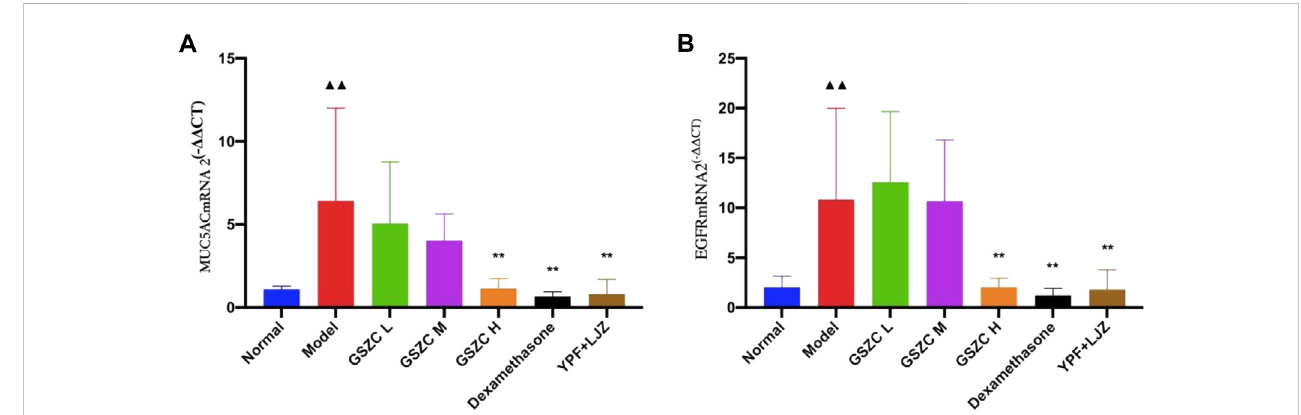
FIGURE 9 Effects of GSZC granules on lung MUC5AC (A) , EGFR (B) protein expression in rats suffering from asthma. Values are the mean ± SD, n = 6 for each group. ▲▲ p < .01 versus the normal group, * p < .05, ** p < .01 versus the model